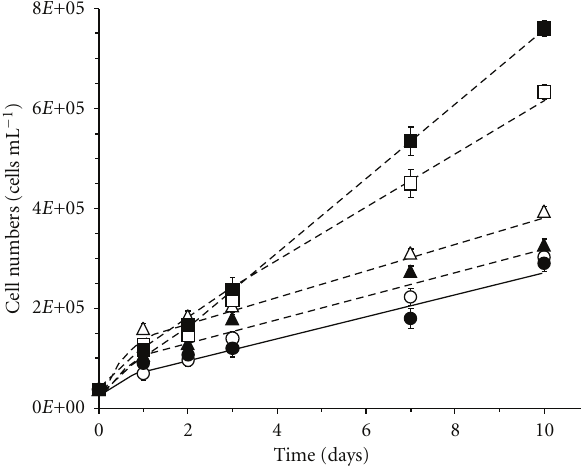
Figure 8: Change in growth of olfactory ensheathing cells (no. mL − 1 ) when cultivated on PHB/PEG composite films with di ff erent PEG loadings (% w/w); ( ◦ ) cell culture dish, ( • ) PHB film, PHB/PEG106 films with 20 ( Δ ) and 30 ( (cid:3) ) % w/w loadings, PHB/ PEG2000 films with 20 ( (cid:2) ) and 30 ( (cid:4) ) % w/w